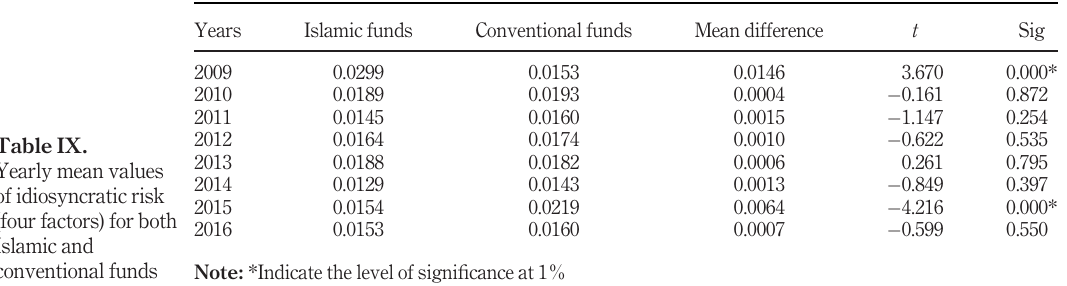
Table IX. Yearly mean values of idiosyncratic risk (four factors) for both Islamic and conventional funds